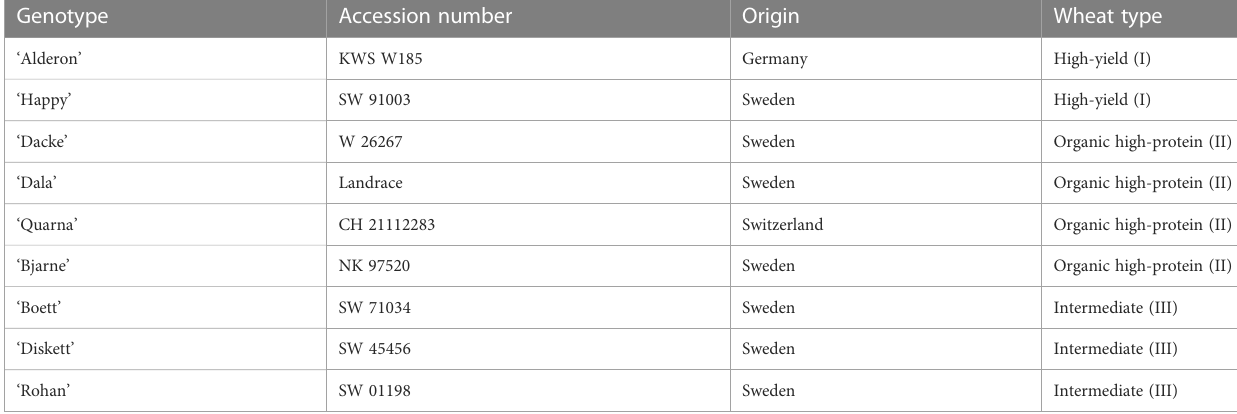
TABLE 1 List of the nine-spring wheat varieties used in this study, their origin, and the classi fi cation to their breeding target.